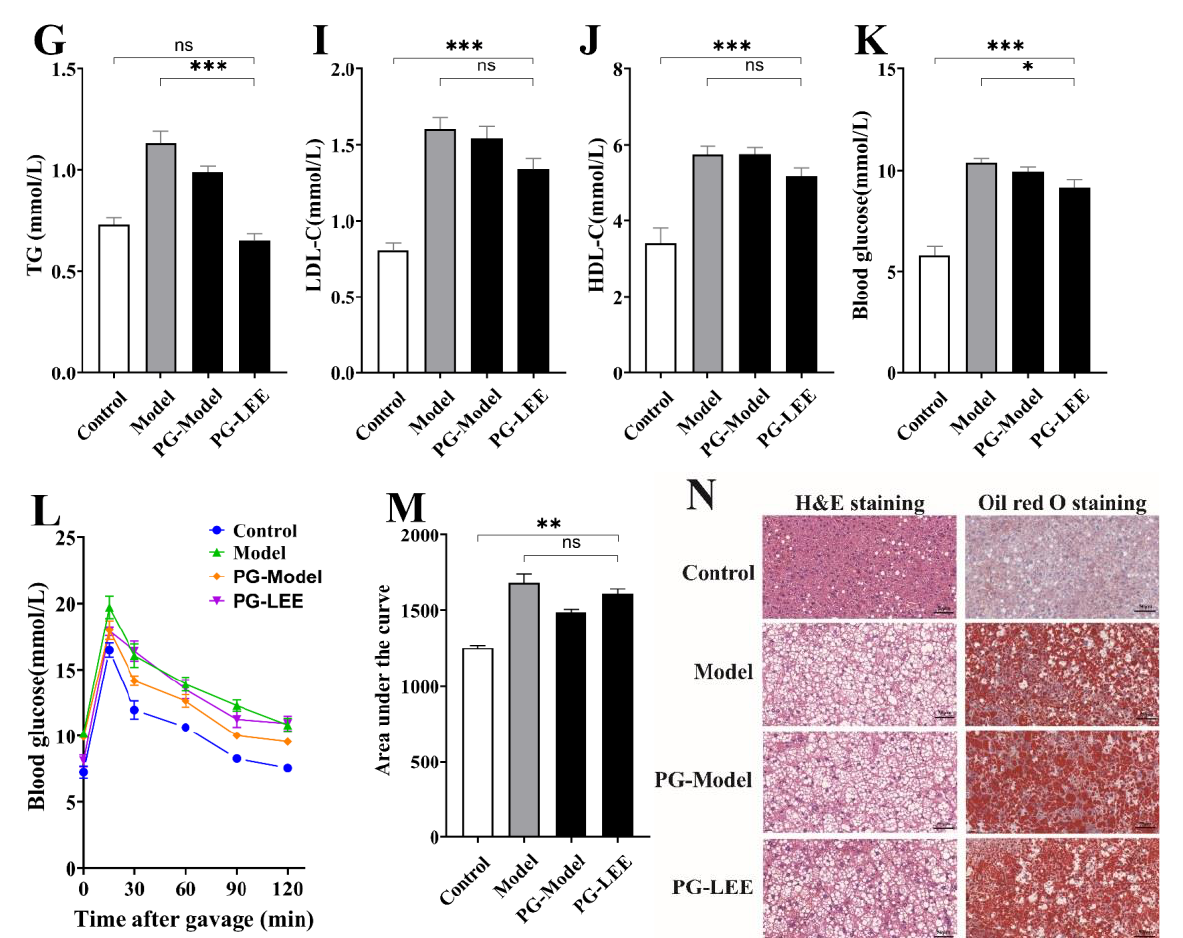
Figure 6. Effect of LEE on pseudo-germ-free mice with HFD. ( A ) Relative abundance at the phylum level. ( B ) Body weight gain after administration. ( C ) Liver weight. ( D ) epiWAT weight. ( E ) intBAT weight. ( F ) Food intake. Serum TC ( G ), TG ( H ), LDL-c ( I ), HDL-c ( J ), blood glucose ( K ), OGTT ( L ), area under the OGTT curve ( M ), and staining of liver tissue sections (×400) ( N ). Data are expressed as the mean ± SEM ( n = 6). * p < 0.05; ** p < 0.01; *** p < 0.001; ns, not significant.